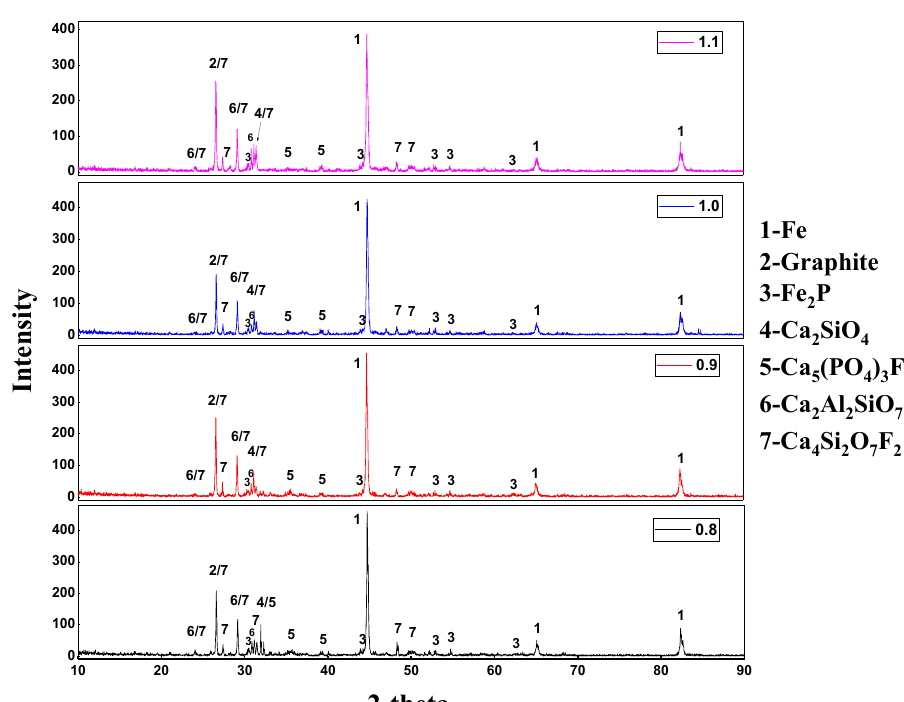
Figure 5. XRD spectra of reduced pellets at different carbon contents.